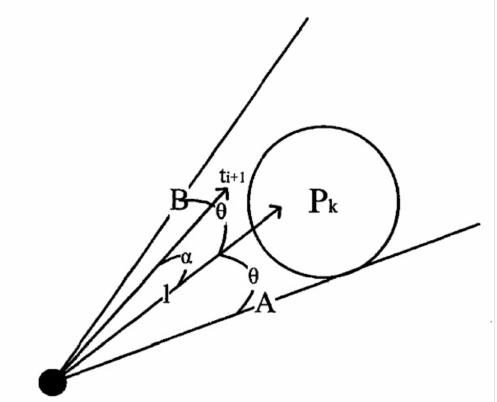
Figure 9. The diagram of dynamic step size adjustment chart. P k represents the k -th threat source, t i+1 is next new node, θ is the maximum turning angle constraint, α is the angle difference between t grow , t i+1 and → l